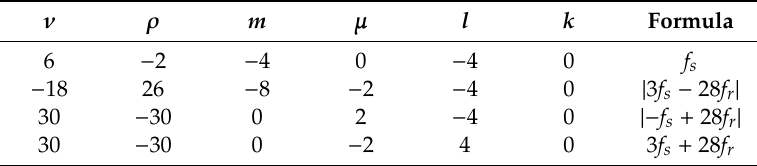
Table 4. Harmonic orders and formulas for the static eccentricity